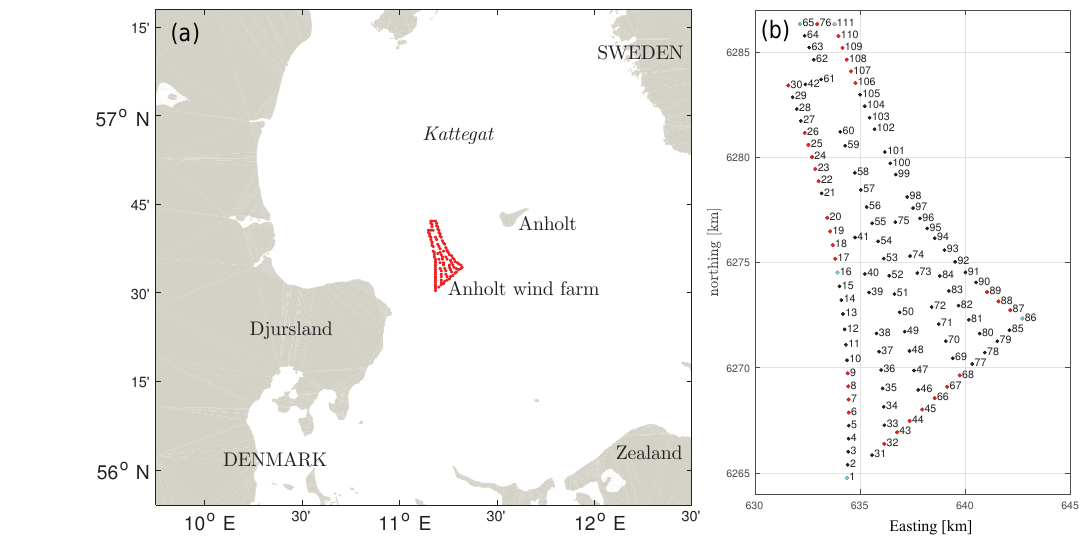
Figure 1. (a) The Anholt wind farm (red markers) in the Kattegat. (b) The layout and numbering of the turbines of the Anholt wind farm in UTM32 WGS84. Turbines used to derived the inflow conditions are shown in red and cyan markers.